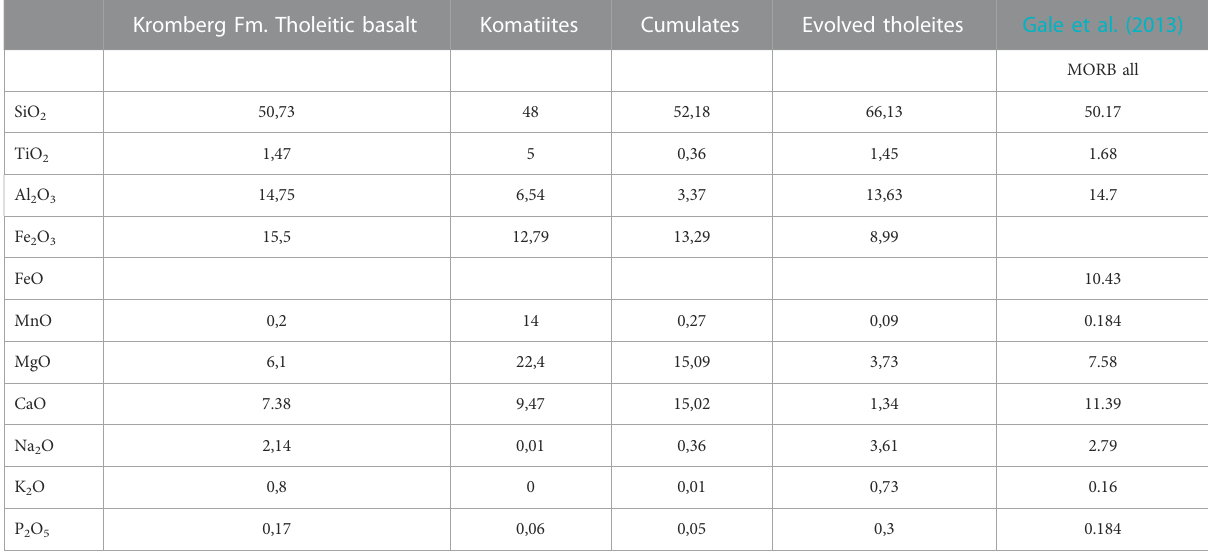
TABLE 2 Elemental compositions of Archaean basalts (tholeites, komatiites, cumulates and evolved tholeites from the Kromberg Formation, Barberton Greenstone Belt, South Africa) from Vennemann and Smith (1999) compared with Mid-Ocean Ridge Basalts from Gale et al. (2013). Kromberg Fm. Tholeitic basalt